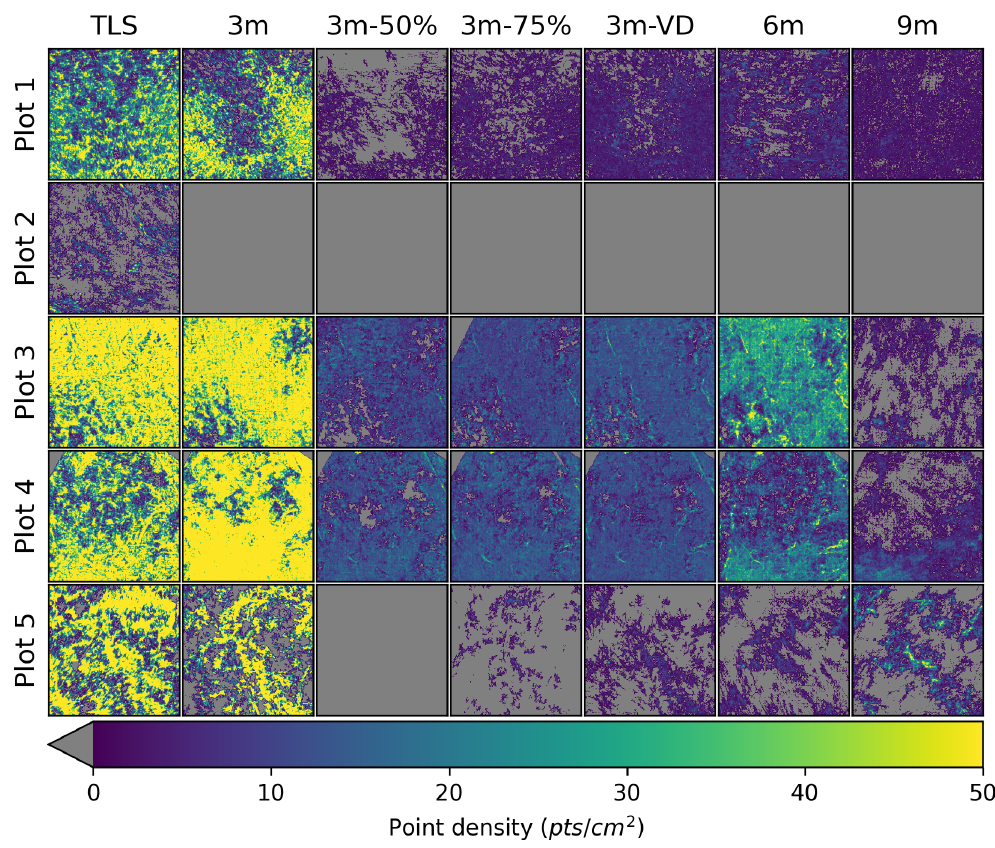
Figure 3. Point density and horizontal coverage of each data capture indicated on 1cm grid for each plot where examples for sub-sampled image combinations were randomly selected. (Plot 1 = manicured turf, Plot 2 = native tall grass, Plots 3 and 5 = dry sclerophyll forest, Plot 5 = low